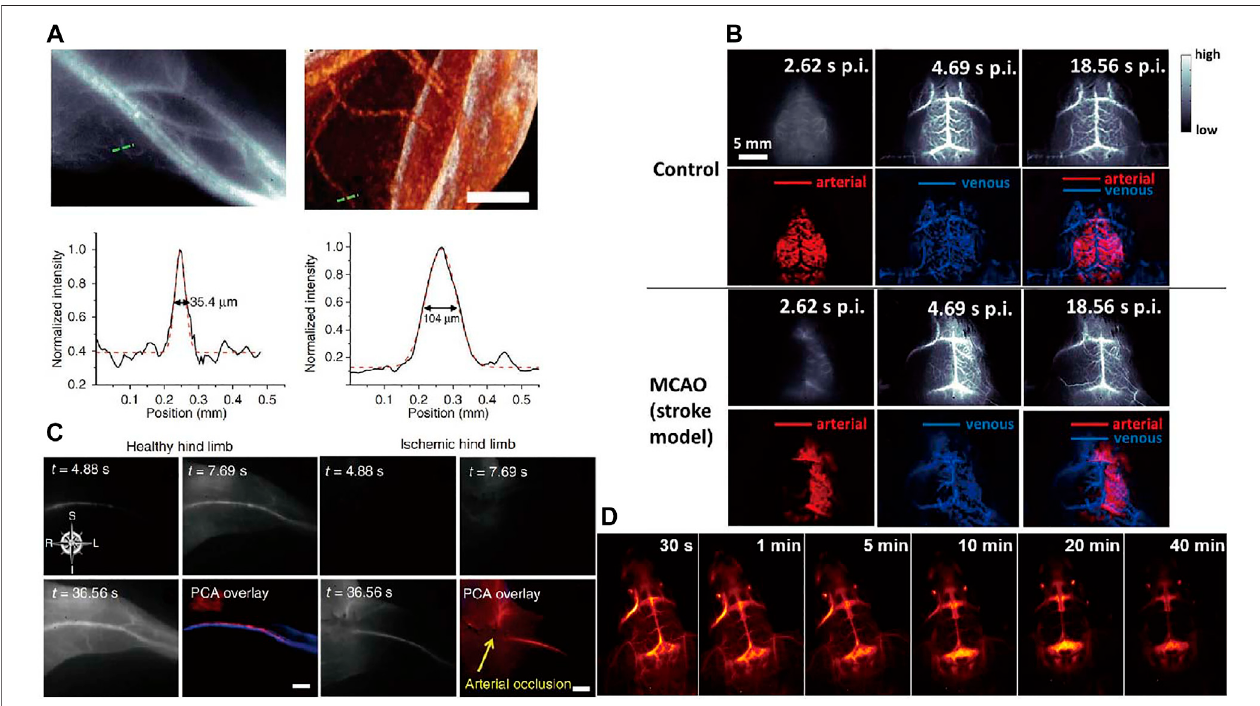
FIGURE 6 | Vessel imaging. (A) Comparison of NIR-II fl uorescence and micro-CT imaging of hind limb blood vessels (Hong et al., 2012). Reproduced with permission from Dai et al. (2012). (B) Dynamic NIR fl uorescence imaging of mouse cerebral vasculature (Hong et al., 2014). Reproduced with permission from Dai. (2014). (C) Principal component analysis (PCA) of femoral artery and vein in healthy and ischemic mice by NIR-II imaging. (Hong et al., 2012). Reproduced with permissionfrom Daietal.(2012). (D) Real-timeimagingofbrainvessels usingPAA-modi fi ed β -NaErF 4 @NaYF 4 NPsthroughintravenousinjection viathetailvein(Li et al., 2020c). Reproduced with permission from Chen et al.